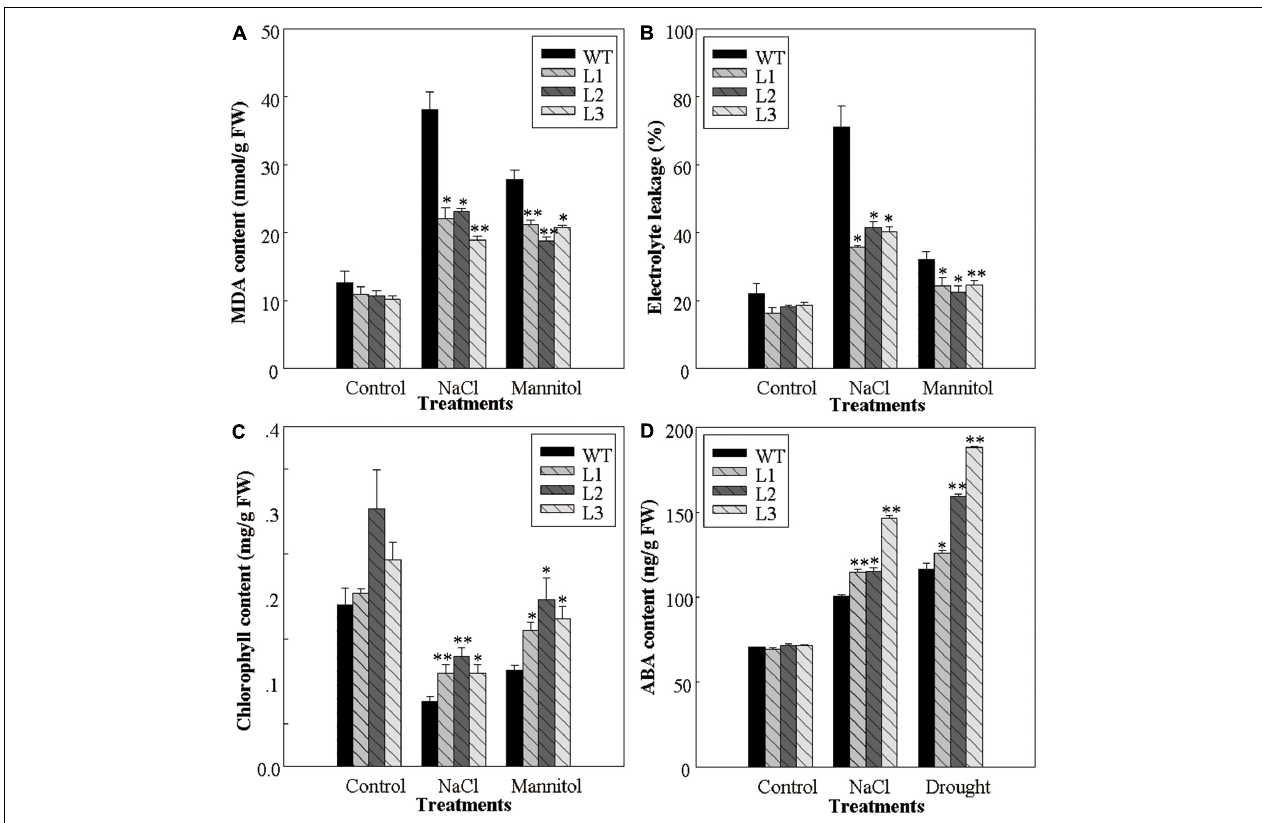
FIGURE 2 | Physiological changes associated with osmotic stress response in WT and VlWRKY3 transgenic Arabidopsis thaliana seedlings. (A,C,D) Malondialdehyde (MDA) content (A) , Chlorophyll content (C) and abscisic acid (ABA) content (D) in the leaves of WT and transgenic seedlings grown with or without osmotic stress, respectively. (B) Relative electrolyte leakage from detached leaves of WT and transgenic seedlings grown with or without exposure to osmotic stress. In all cases, data values represent means ± SD from three independent experiments. Asterisks indicate statistical significance ( ∗ 0.01 < P < 0.05, ∗∗ P < 0.01, Student’s t -test) of differences between transgenic lines and WT